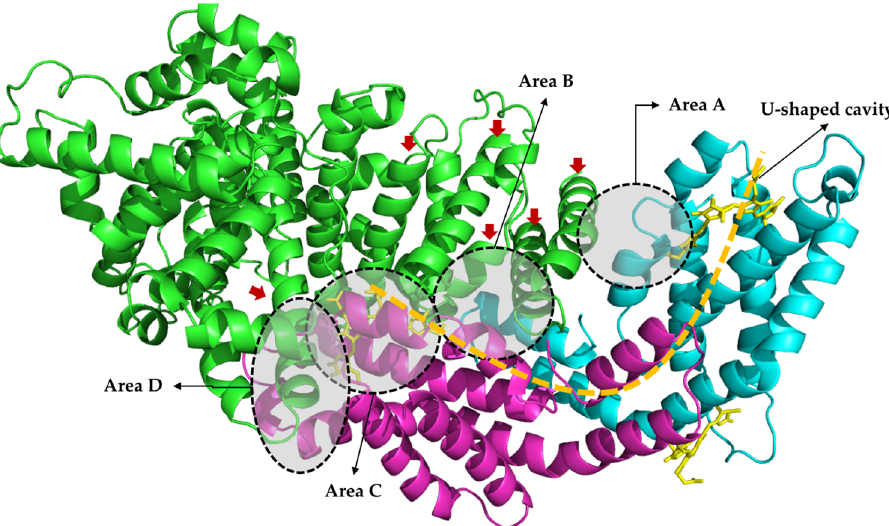
Figure 4. Interaction of BSA (PDB id: 4f5s) and C-phycocyanin (PDB id: 2vjr) using molecular docking. Solvent molecules were removed before molecular docking. The green chain is BSA. α and β subunits of C-phycocyanin are colored in pink and blue, respectively, whereas phycocyanobilin is yellow. Red arrows represent the BSA α -helices blocked by C-phycocyanin.